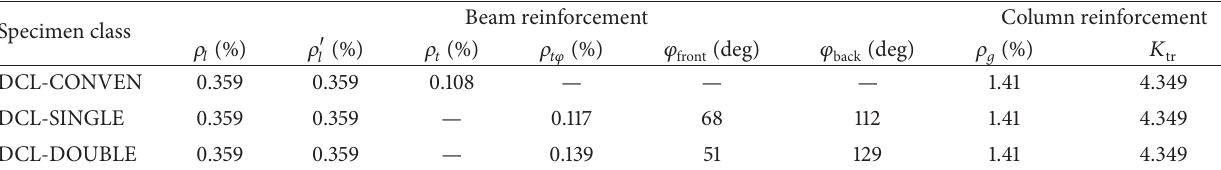
Table 1: Reinforcement details of